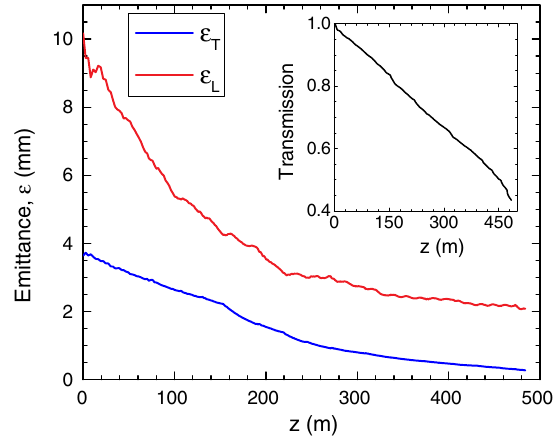
FIG. 7. Simulation results of the performance of a tapered 6D cooling channel for a muon collider. The plot shows the evolu- tion of the normalized rms emittances and transmissions as a function of distance along the channel. At z ¼ 480 m the trans- mission is 45% with muon decays, while the final emittances are ¼ 0 : 27 mm and " ¼ 2 : 0 mm " T L